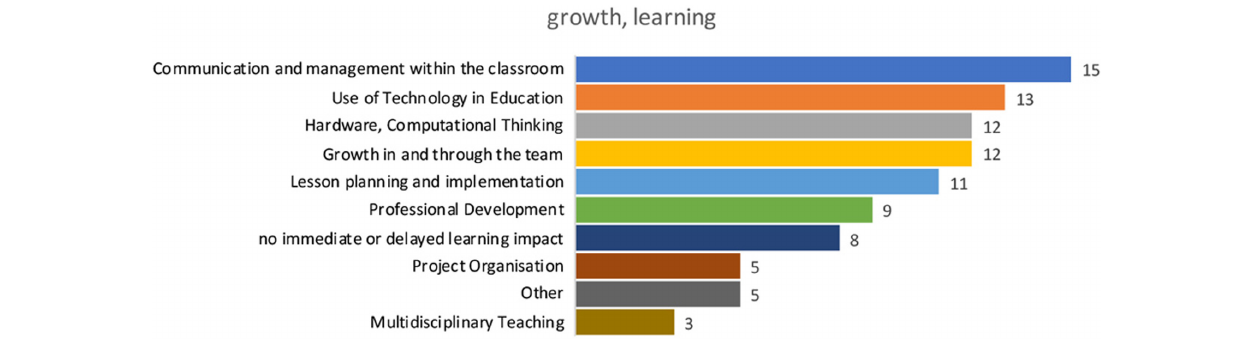
FIGURE 4 | Frequencies of interviews with mentions of the listed categories regarding growth and learning in the project.